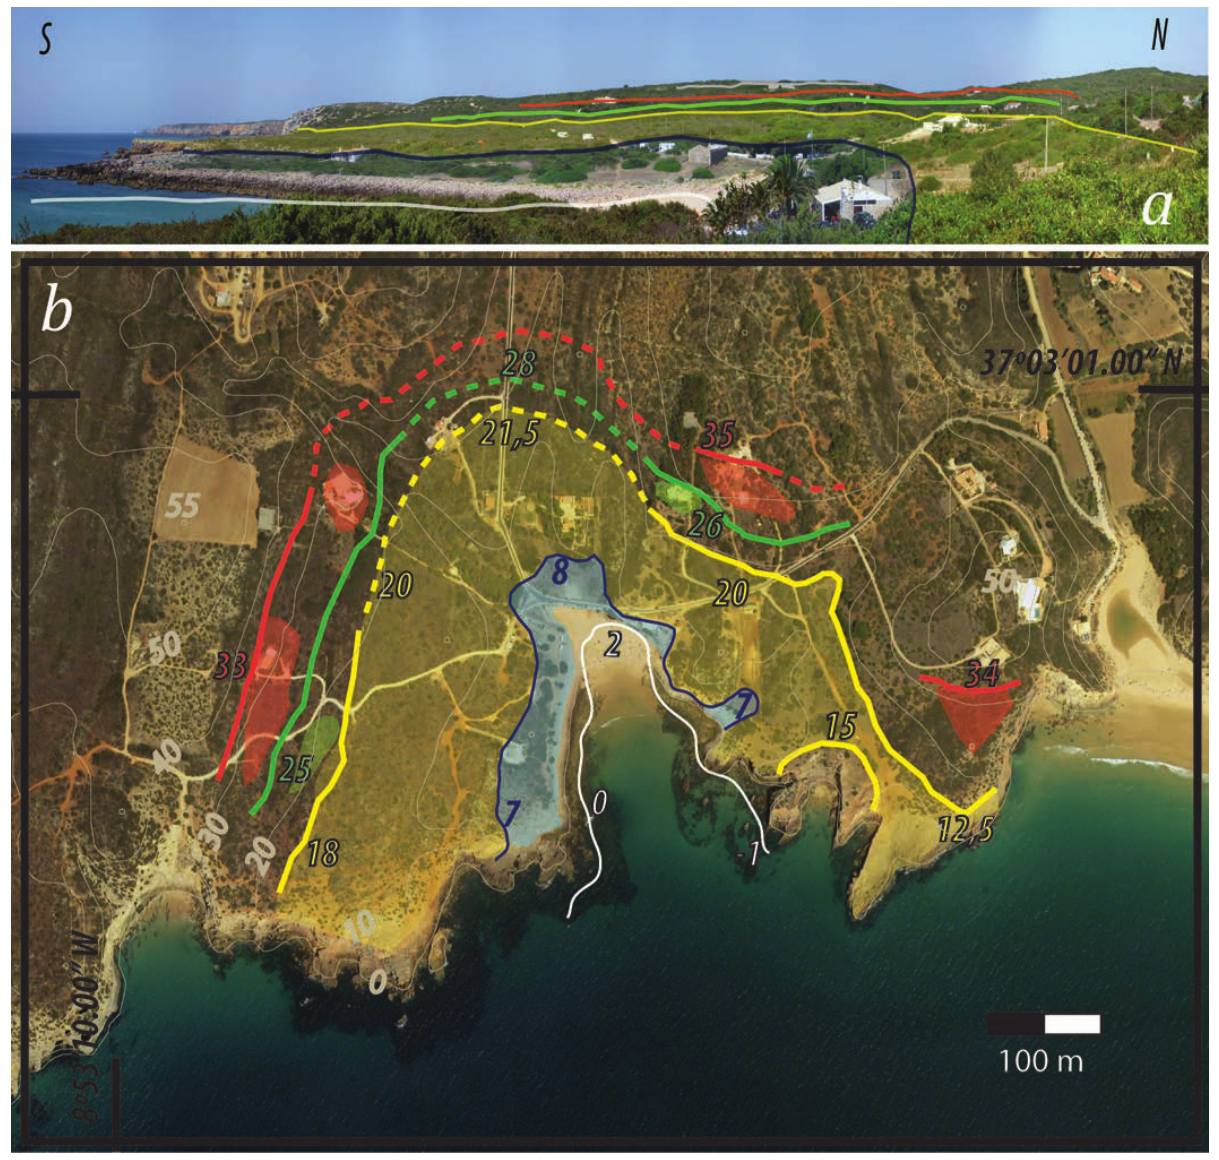
Figure 4. Map identifying the marine terrace at the Ingrina site. a) Panoramic view from east and terrace perspective. b) Inner edge and ter- race map. Terraces are mapped in transparent colors and the inner edges in solid line when visible and dashed line when inferred. White-T0 (modern); blue-T1; yellow-T2; green-T3; red-T4. Inner edges elevations in meters are provided. Topography contours lines each 10